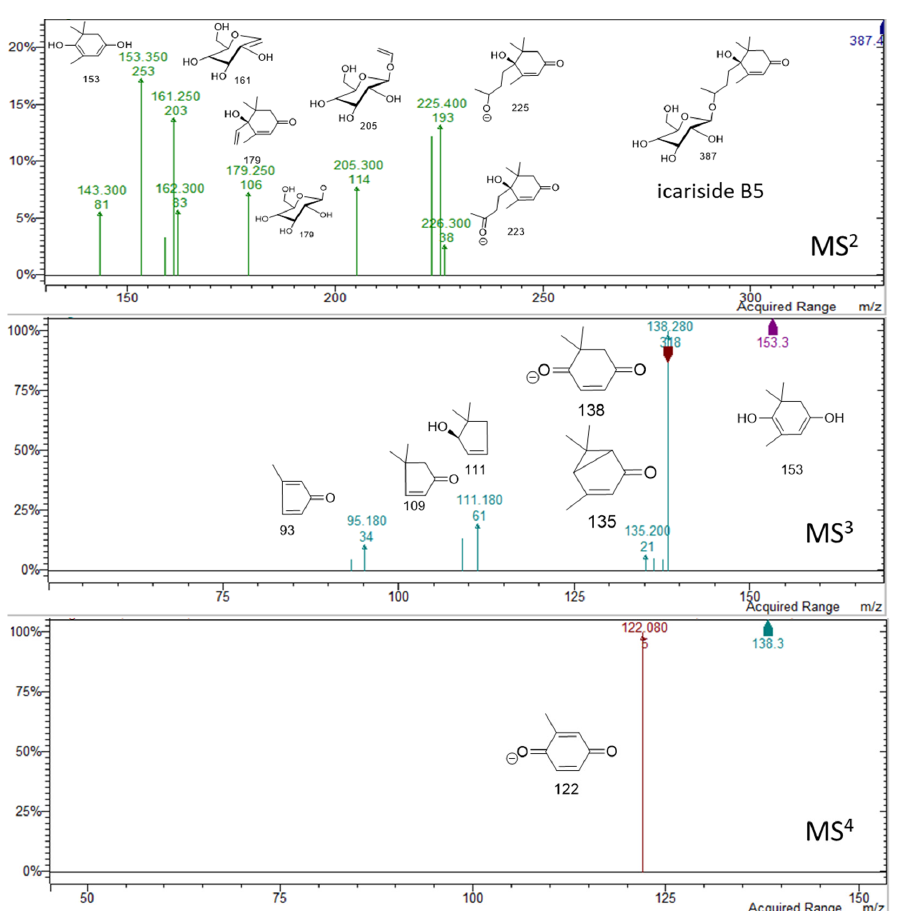
Figure 5. Spectral and fragmentations of icariside B5: MS 2 from parent ion 387 m/z , MS 3 from fragment 153 m/z , MS 4 from fragment 138 m/z.